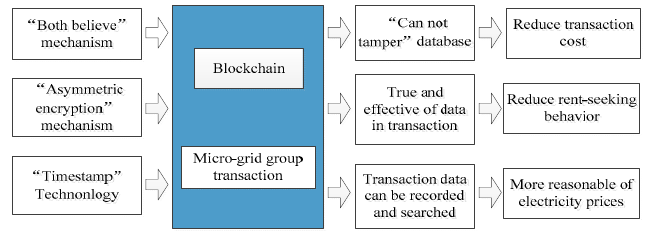
Figure 3. Trading mechanism coupling.